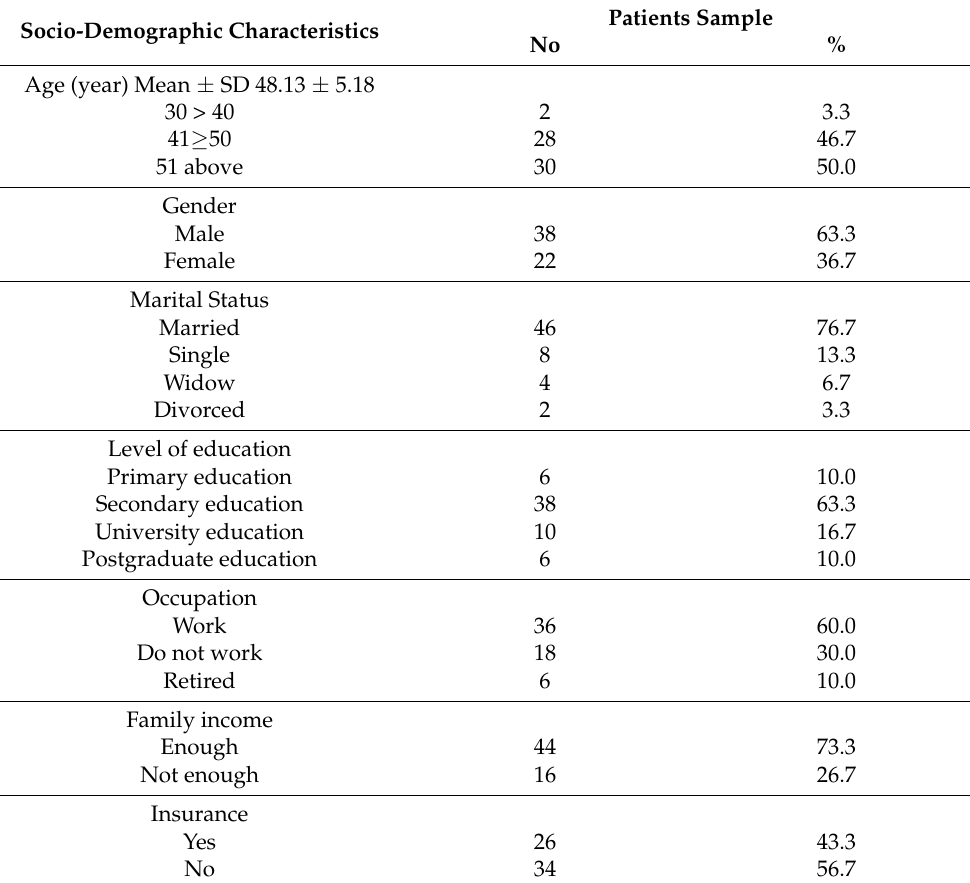
Table 1. Distribution of patients’ socio-demographic characteristics (n = 60).